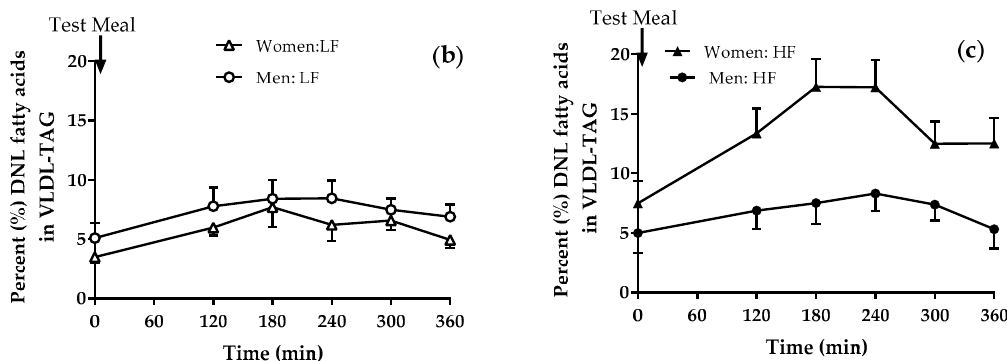
Figure 2. The contribution (%) of DNL fatty acids to VLDL-TAG in ( a ) the whole group after the consumption of the low fructose (LF) and high fructose (HF) meals ( P < 0.001 time, P = 0.05 meal, time × meal P = 0.06); ( b ) women and men after consumption of the low fructose (LF) meal ( P < 0.001 time); and ( c ) women and men after consumption of the high fructose (HF) meal ( P < 0.001 time, P < 0.05 sex, P < 0.01 time × sex interaction). Data presented as mean ± SEM.